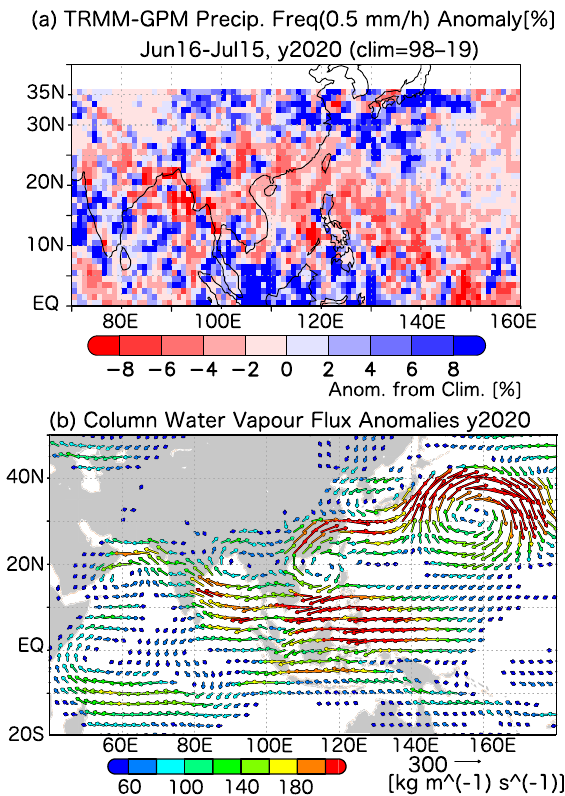
Figure 1. Maps of ( a ) precipitation and ( b ) vertically-integrated water vapour flux anomalies in the 2020 Meiyu–Baiu season, as compared to the mean climate, defined as the 22-year mean for 1998–2019 for all meteorological variables. The Meiyu–Baiu season was assumed to occur from 16 June to 15 July every year (for plotting, see Methods). In ( b ), water vapour fluxes smaller than 40 kg/m/s were omitted from the plotted data. Figure generated with GrADS 2.2.1 (http:// cola. gmu. edu/